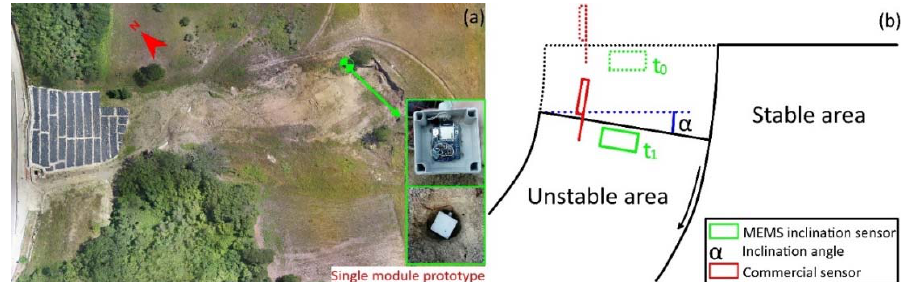
Figure 3. The ( a ) Pietrafitta landslide as seen from an orthoimage. The green point indicates the position of installation of the single ‐ module prototype during the field test; Schematic ( b ) showing the geometry of deformational structures monitored and the expected kinematic of the movement.